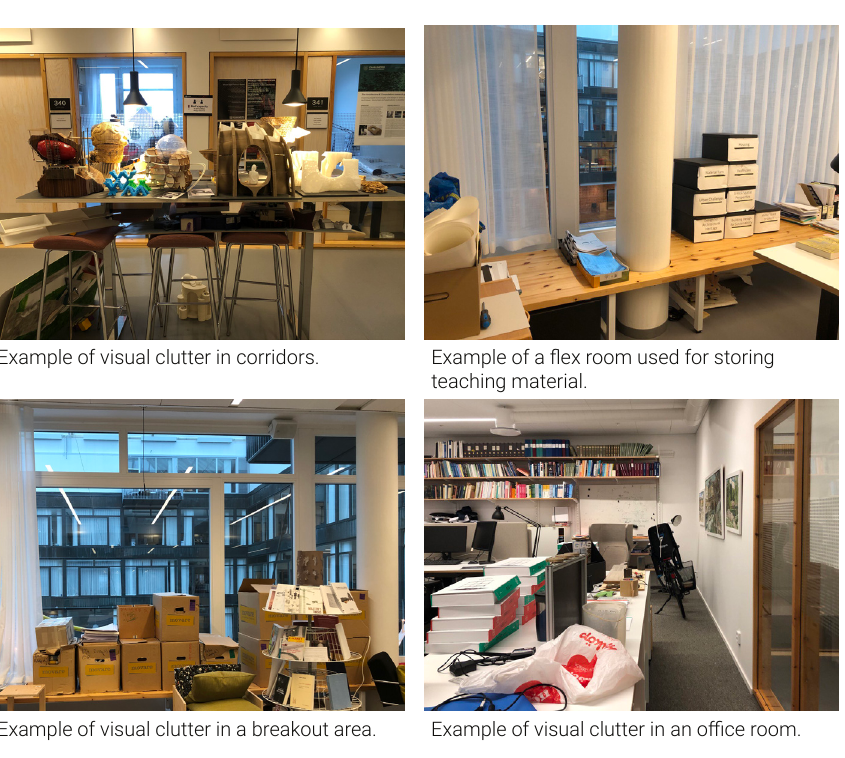
Figure 13. Visual